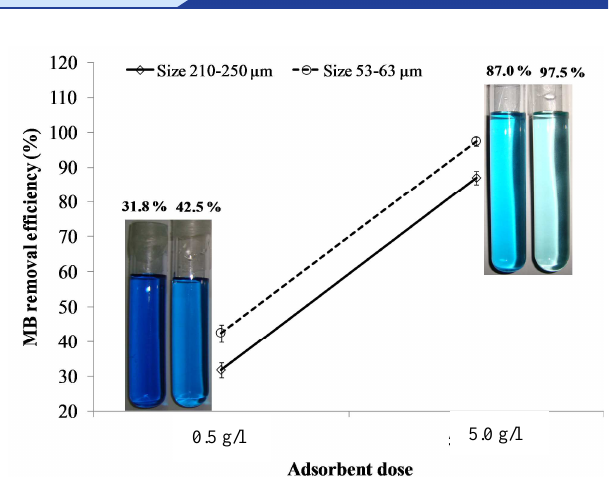
Figure 6. Particle size effect of acid-activated spent tea (AAST) on methylene blue (MB) adsorption efficiency (pH = 7.0 ± 0.1; time = 120 min, C = 50 mg/l) o